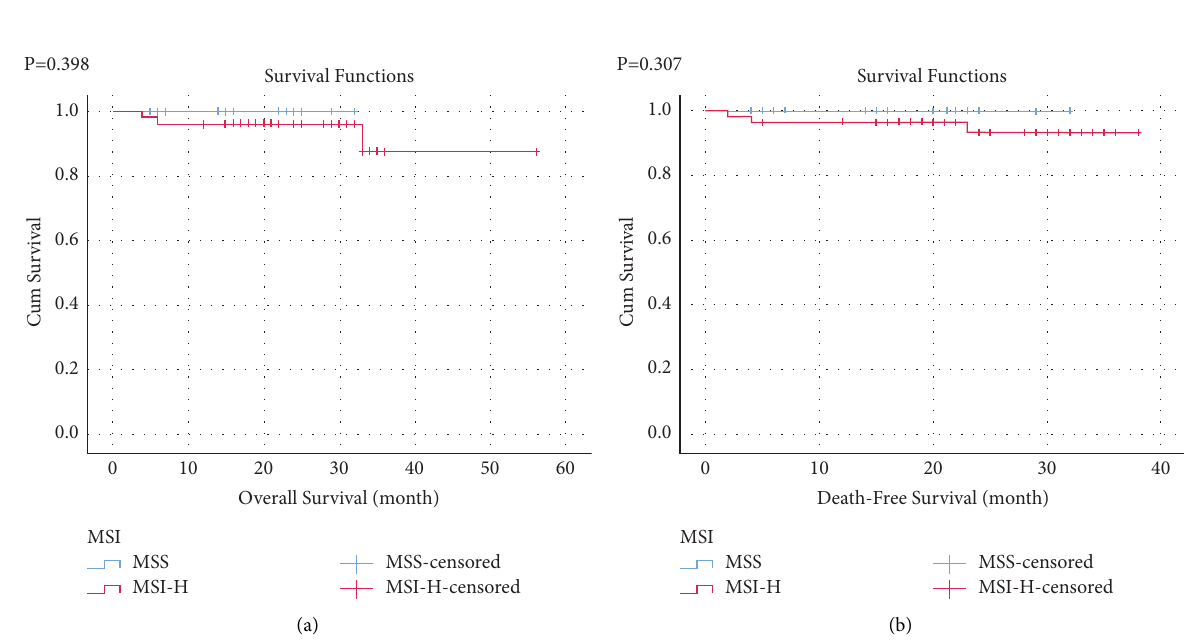
Figure 2: Survival curves of the two groups. (a) P � 0 . 398. (b) P � 0 .